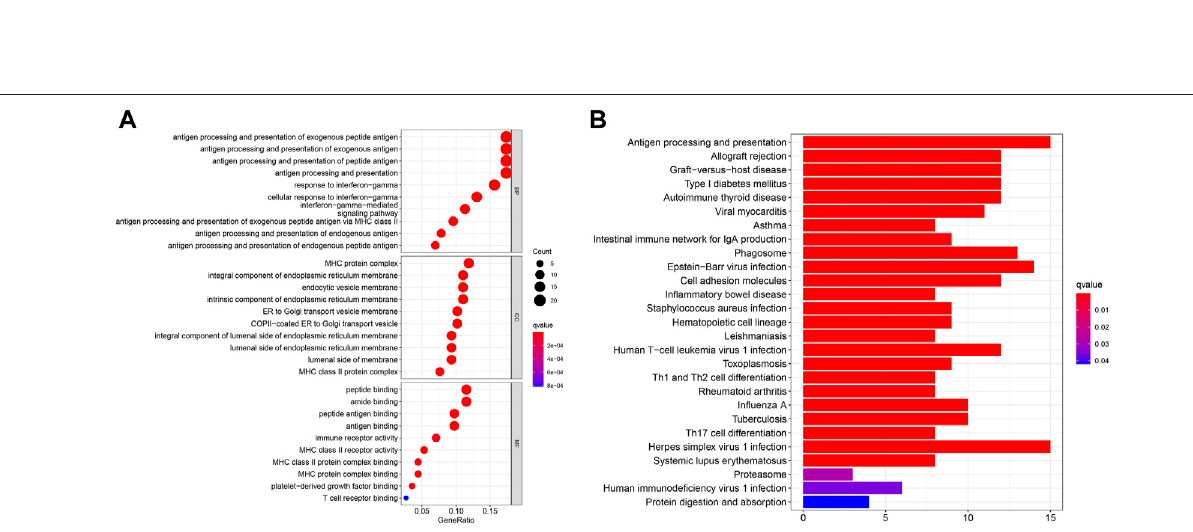
Frontiers in Genetics |